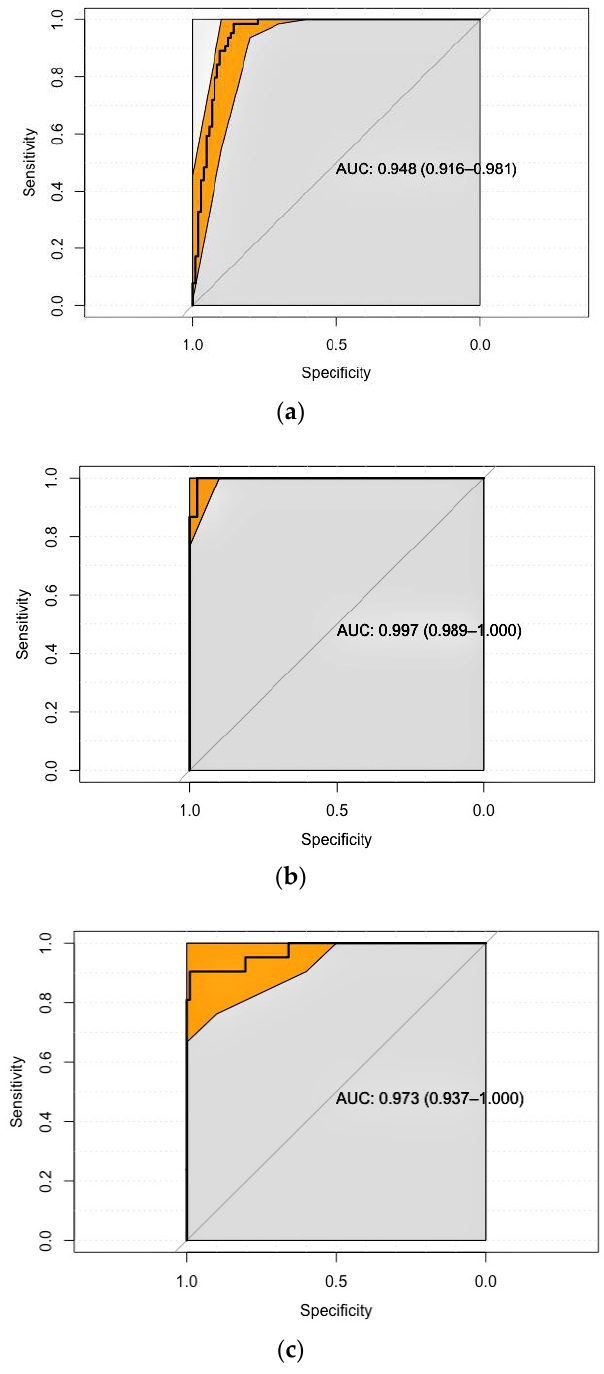
Figure 2. Plot of the receiver operating characteristic (ROC) curve analysis for M. bovis ( a ), B. suis ( b ), and T. spiralis ( c ).